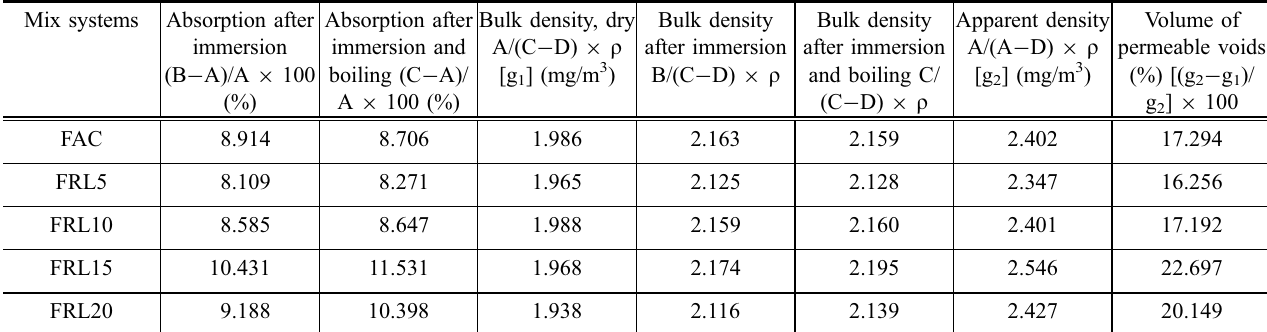
Table 5 Volume of permeable voids for various